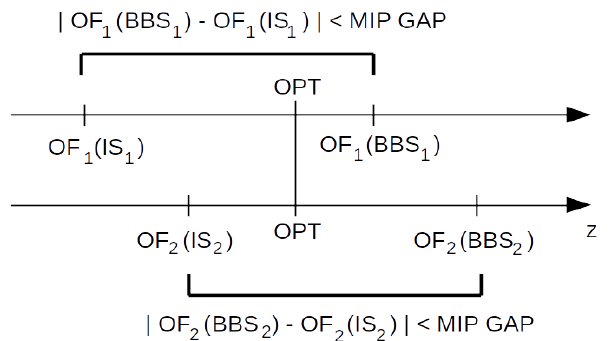
Figure 4. OF results for independent optimisations of equivalent problems (z: OF axis; OPT: optimal OF